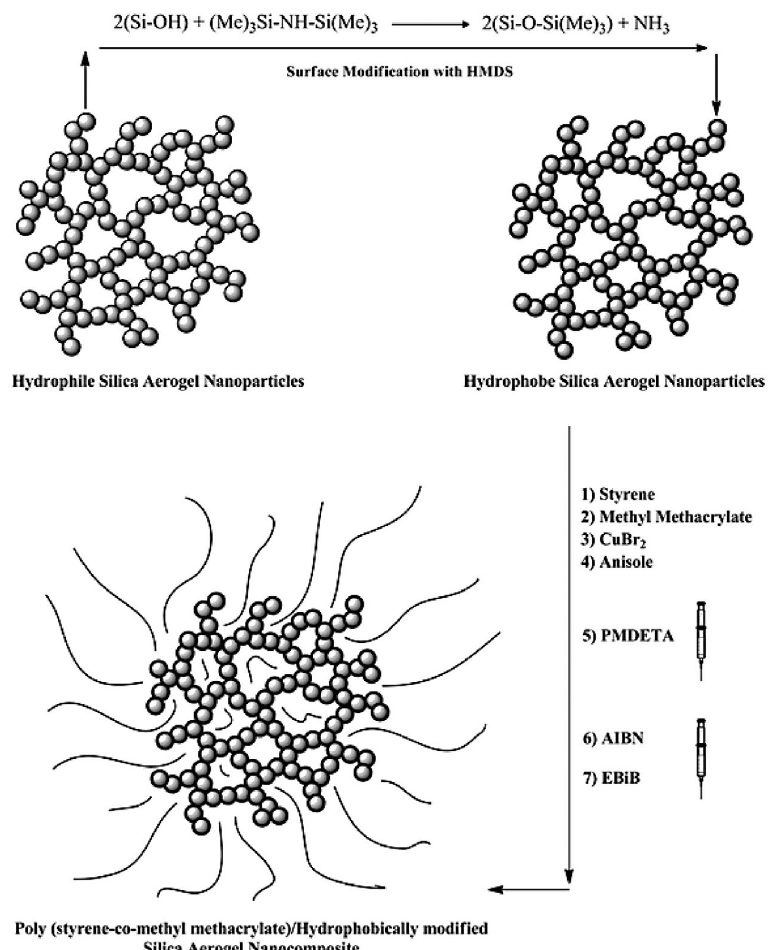
Figure 4. General procedure for preparation of poly (styrene-co -methyl methacrylate)/H-SAN nanocomposites by in situ SR&NI ATRP